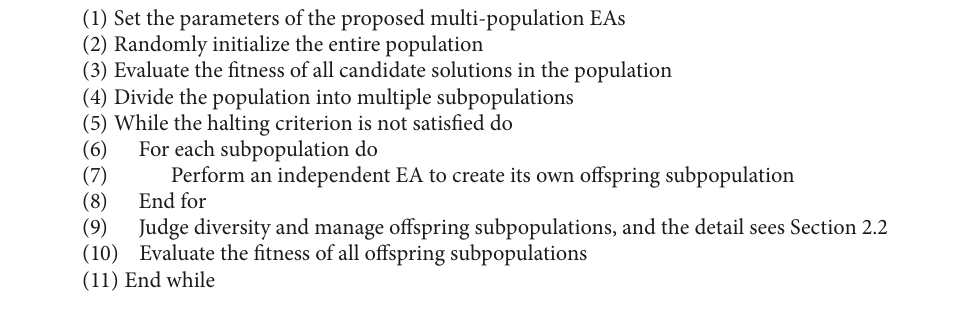
Algorithm 1: Pseudocode of the proposed multipopulation